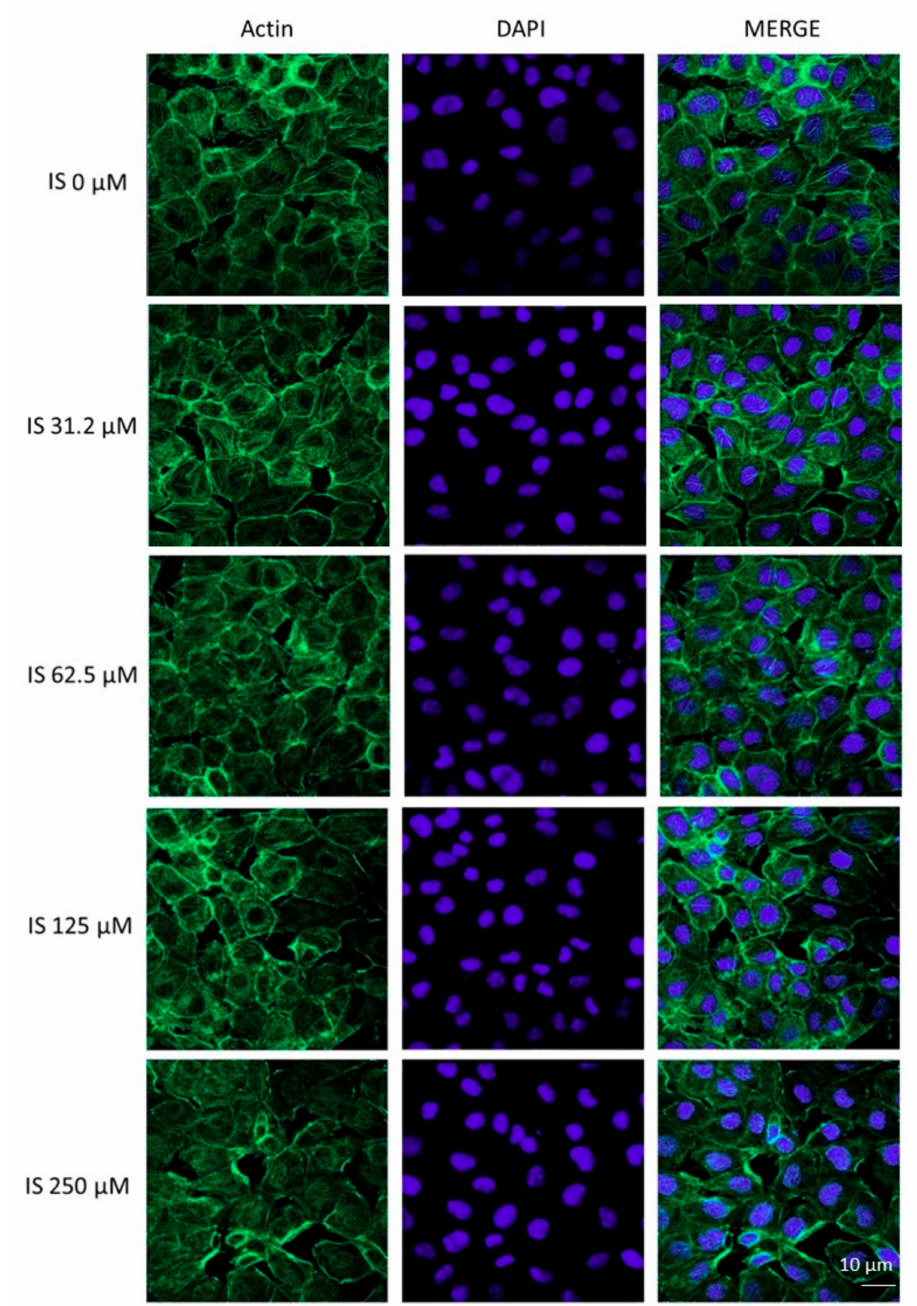
Figure4. E ff ectofIS(31.2–250 µ M)ontheactinstressfibresassemblyinIEC-6cells. Immunofluorescence analysis was performed using immunofluorescence confocal microscopy ( n = 15). Scale bar, 10 µ m. Blue fluorescence indicated the localization of nuclei (DAPI) and green indicated the localization of actin stress